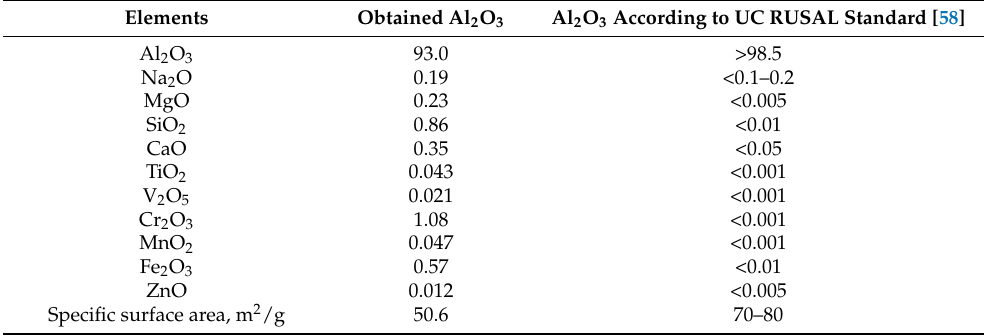
Table 6. Comparison with standard requirements of Al 2 O 3 obtained by calcination of ACH at 800 ◦ C for 60 min followed by water leaching and the same calcination, wt.%.